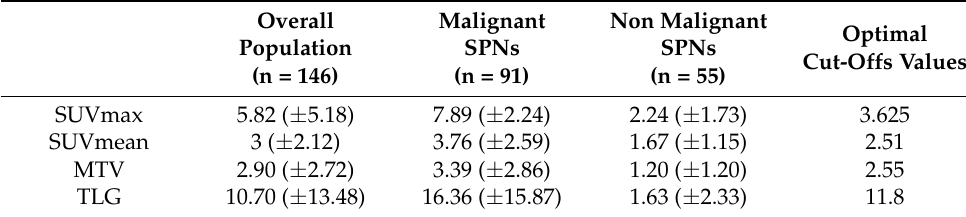
Table 4. Median (MAD) values and optimal cut-offs of maximum standardized uptake value (SU- Vmax), mean standardized uptake value (SUVmean), metabolic tumor volume (MTV) and total lesion glycolysis (TLG) FDG PET parameters.